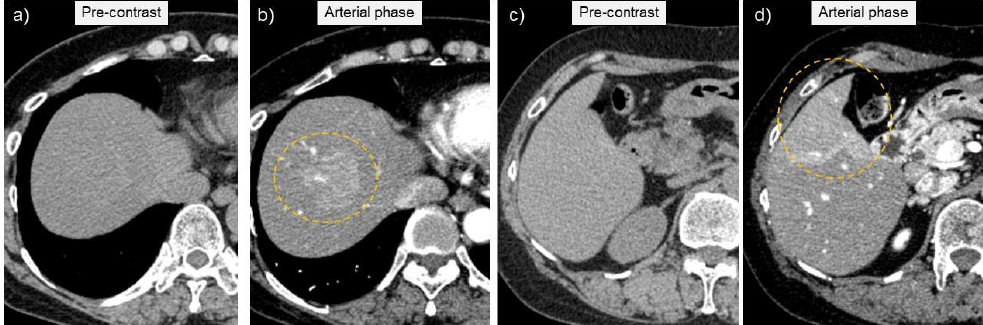
Figure 3. Computed tomography depicted tumor lesions at segments S8 ( a ) and S5 ( c ) in the liver as low and iso-density